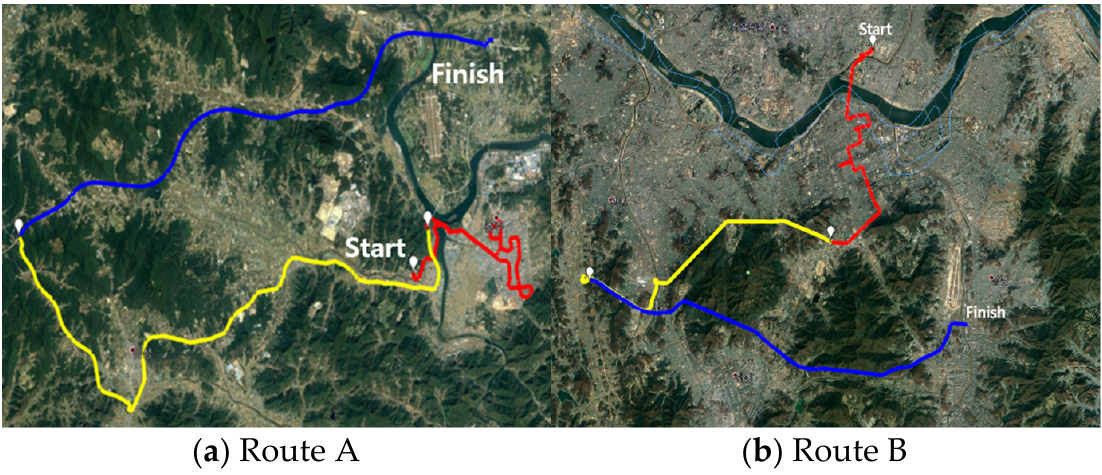
Figure 3. Map of RDE routes—Urban (redline), Rural (yellow line), Motorway (blue line).